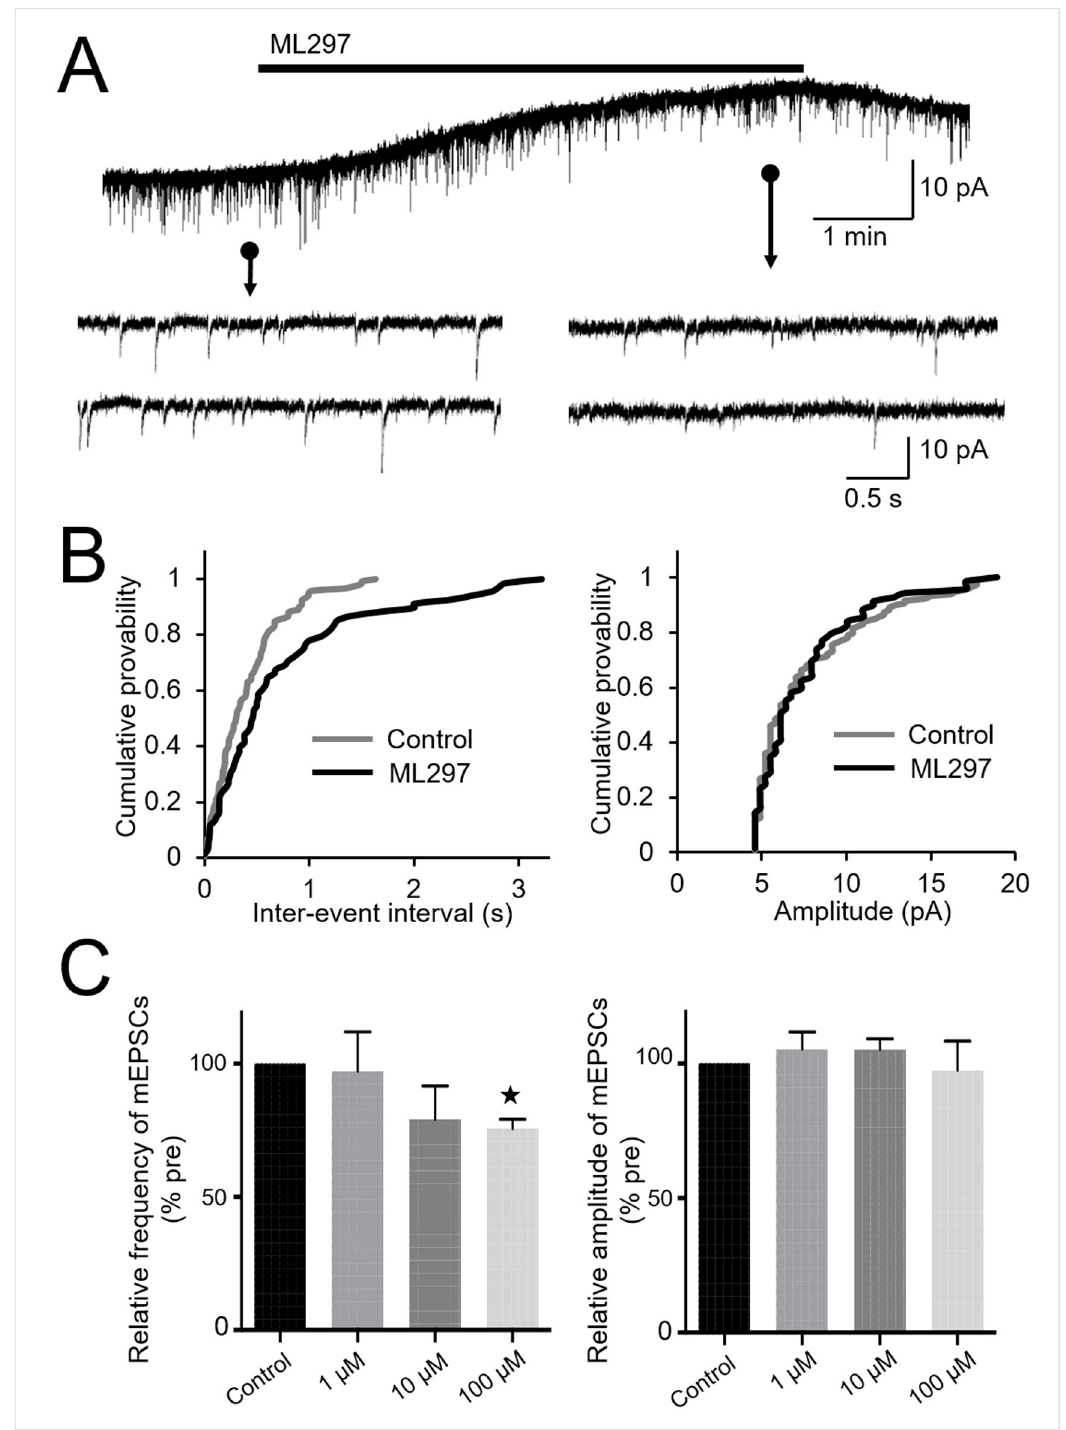
Fig 4. Effects of ML297 on mEPSCs. (A) Representative recording of mEPSCs before (left) and after (right) administration of 100 μ M ML297. (B) Cumulative distribution of the inter-event interval and amplitude of mEPSCs recorded before application (grey line) and in the presence (black line) of 100 μ M ML297. ML297 did not affect the distribution of the amplitude (P = 0.99, right), but shifted the distribution to a longer inter-event interval (P < 0.05, left). (C) Summary of normalized frequencies (left) and amplitudes (right) of mEPSCs relative to the pre-application base line levels. ML297 at 100 μ M, but not at lower concentrations of 10 and 1 μ M,